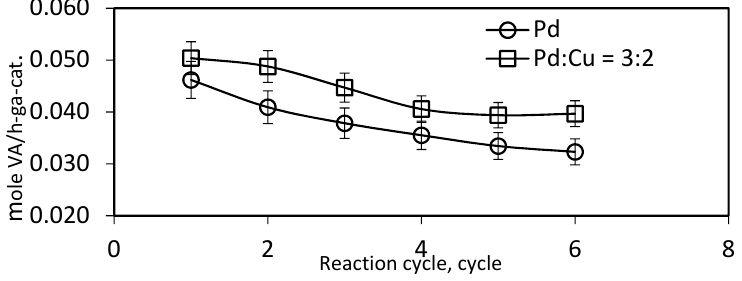
Figure 6. The vinyl acetylene reaction rate of Pd/Al 2 O 3 and Pd:Cu 3:2 on Al 2 O 3 catalysts as the function of reaction cycles.